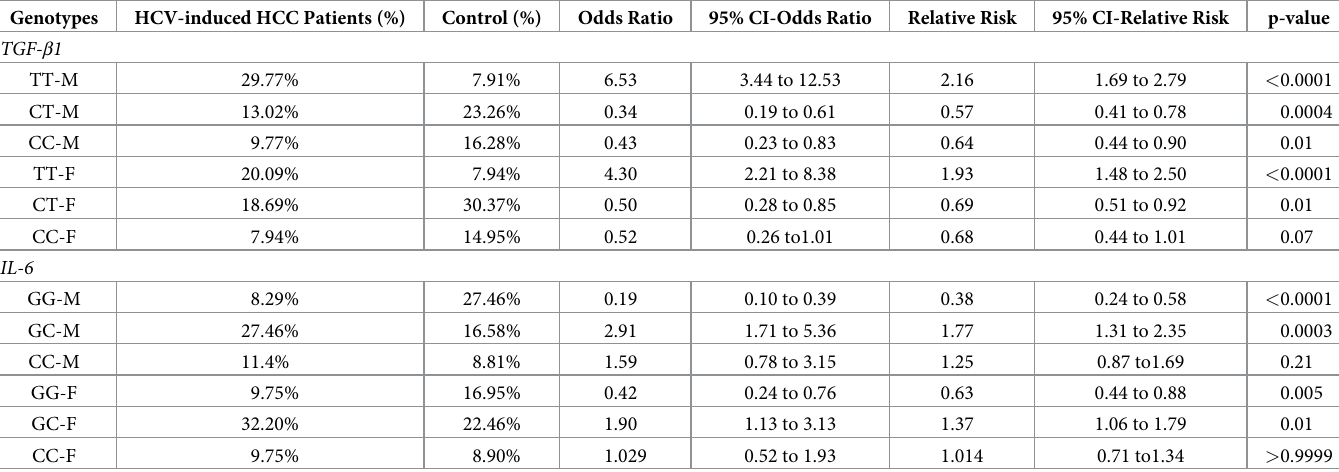
Table 6. Association of TGF β -1 +29 C/T and IL-6–174 G/C genotypes with gender in HCV-induced HCC and control patients. Genotypes HCV-induced HCC Patients